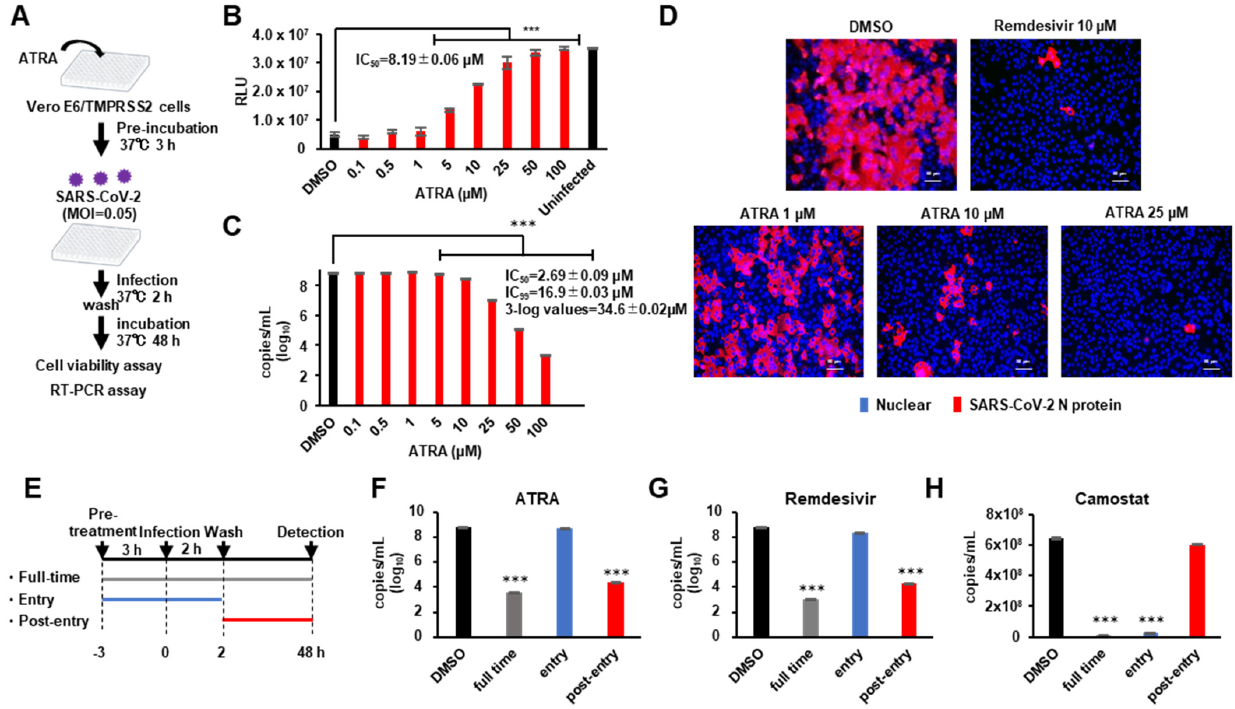
Figure 3. ATRA inhibits SARS-CoV-2 replication ( A ) Assessing the antiviral effect of ATRA in VeroE6/TMPRSS2 cells. VeroE6/TMPRSS2 cells treated with ATRA (0.1–100 µM) for 3 h prior to infection were infected with SARS-CoV-2 (MOI = 0.05) and washed off the unbound virus at 2 h of infection. Cell viability assay and RT-PCR were performed on the attached cells and supernatant culture medium respectively, 48 h after infection. ( B ) The results of the cell viability assay. IC 50 was calculated for the inhibition of SARS-CoV-2 induced cell death. Error bars obtained from triplicate test- ing. p -value < 0.005 (***) ( C ) Viral quantification by RT-PCR. Error bars obtained from duplicate testing. p -value < 0.005 (***) ( D ) Immunostaining of SARS-CoV-2 N protein in infected cells. VeroE6/TMPRSS2 cells treated with ATRA (1, 10, 25 µ M) 3 h before infection were infected with SARS-CoV-2 (MOI = 0.05). After 24 h of infection, cells were fixed with 4% paraformaldehyde and immunostained. Red stained cells represent SARS-CoV-2 N protein, blue-stained nuclei with DAPI. ( E ) Schematic representation of the time of addition assay of ATRA. ( F - H ) The results of RT-PCR for ATRA ( F ), Remdesivir ( G ) and Camostat ( H ). The result of full-time colored grey, entry colored blue, and post-entry colored red. Error bars obtained from duplicate testing. p -value < 0.005